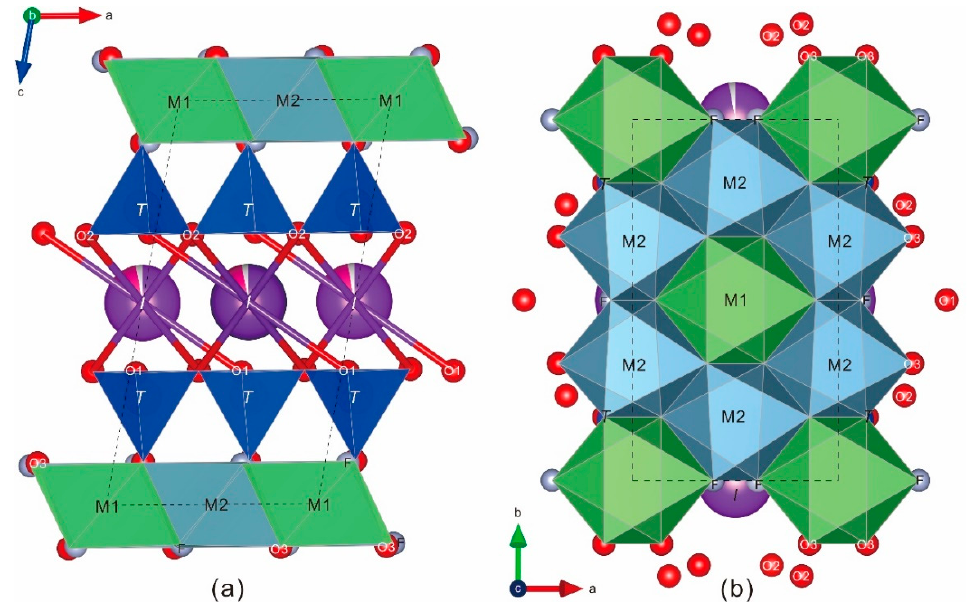
Figure 4. The crystal structure of fluorluanshiweiite: ( a ) view along the b axis and ( b ) view along the c axis. dark blue: Si tetrahedra( T ); green: Li octahedra( M 1); blue-gray: Al octahedra( M 2); purple: I -site. Table 4. Atomic coordinates and isotropic displacement parameters (in Å 2 ) for fluorluanshiweiite. Atom Wyck.